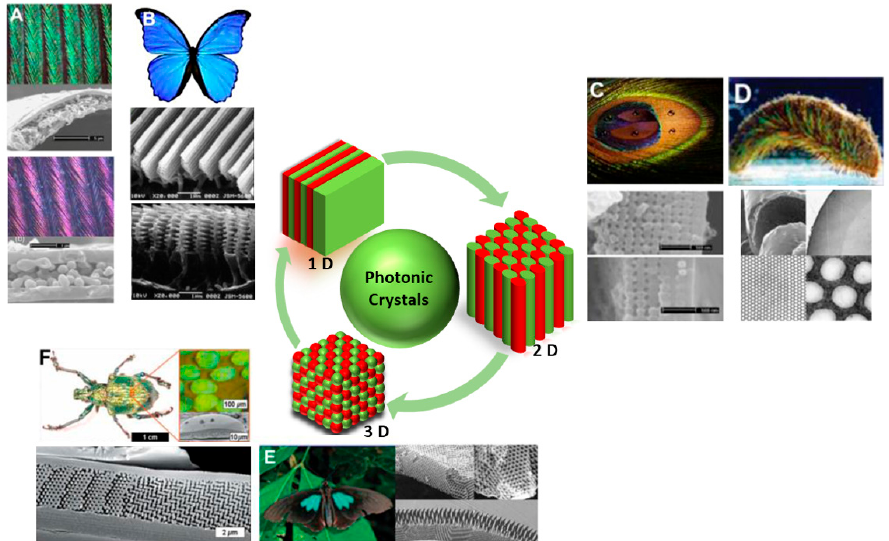
Figure 2. Several examples of natural photonic crystals with various structural colors. ( A ) One-dimensional (1D)—neck feathers of domestic pigeons; ( B ) 1D—wings of Morpho butterflies; ( C ) Two-dimensional (2D)—barbules of male peacocks; ( D ) 2D—iridescent setae from Polychaete worms; ( E ) Three-dimensional (3D)—green spots in the wings of Parides sesostris butterfly; ( F ) 3D— Lamprocyphus augustus beetle. Adapted from [26] under CC BY 4.0 License.